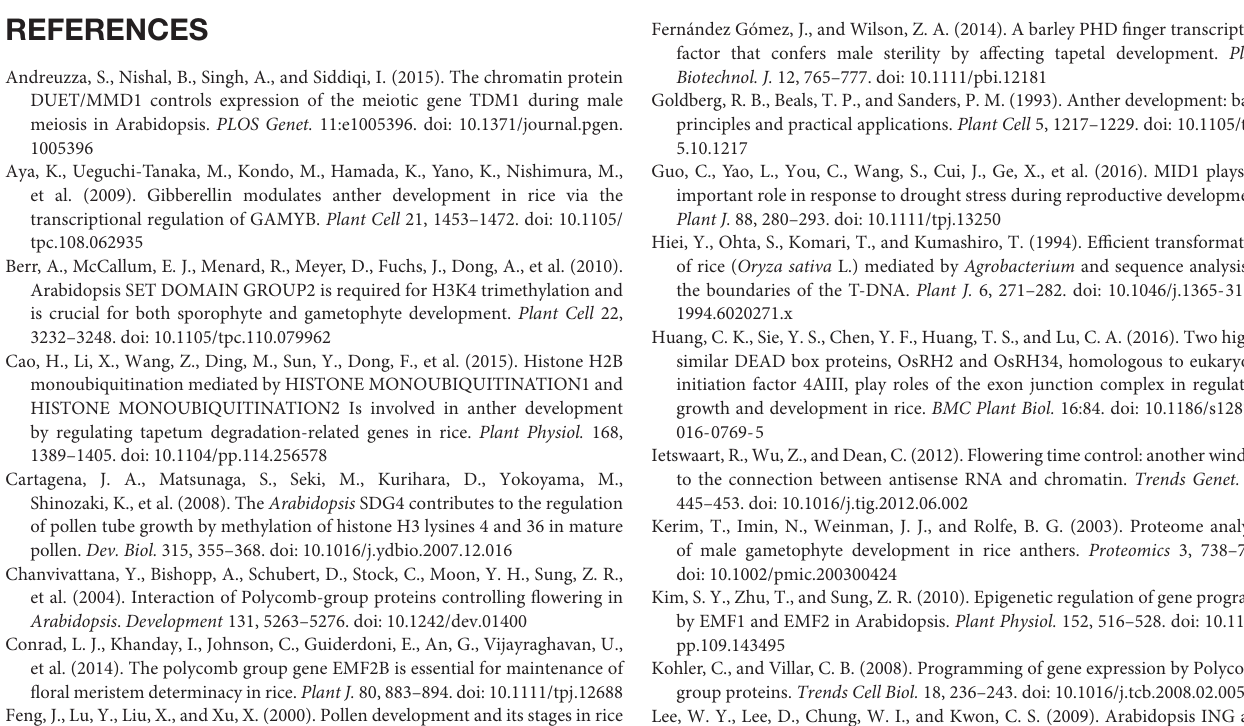
FIGURE S1 | Schematic characterization of four independent mutant alleles of OsEMF2b . Three mutants are T-DNA insertions including osemf2b-1 in intron 19 , osemf2b-2 in intron 10 and osemf2b-4 in this study. The osemf2b-3 mutant is generated by targeting induced local lesions in genomes (TILLIING), and is a guanine to thymine substitution. FIGURE S2 | Phenotype (A,B) and corresponding relative expression levels (C) of osemf2b-4 and complementation plants at heading stage in T 0 progenies. (A) Plant phenotypic comparison. Bars = 10 cm. (B) Observation of inflorescence. Bars = 2 cm. Comp, complementation plants. The white arrows indicated abnormal spikelets. ∗∗ indicates significant difference by Student’s t -test ( P ≤ 0.01). FIGURE S3 | Spikelets after removing the lemma and palea (A–E) and I 2 -KI pollen staining (F–J) of osemf2b-4 and complementation plants. The numbers are percentage of stained pollen grains. Bars = 2 mm and 200 µ m, respectively. TABLE S1 | Segregation of the osemf2b-4 lines in T 1 and T 2 progenies. TABLE S2 | Primers used in this